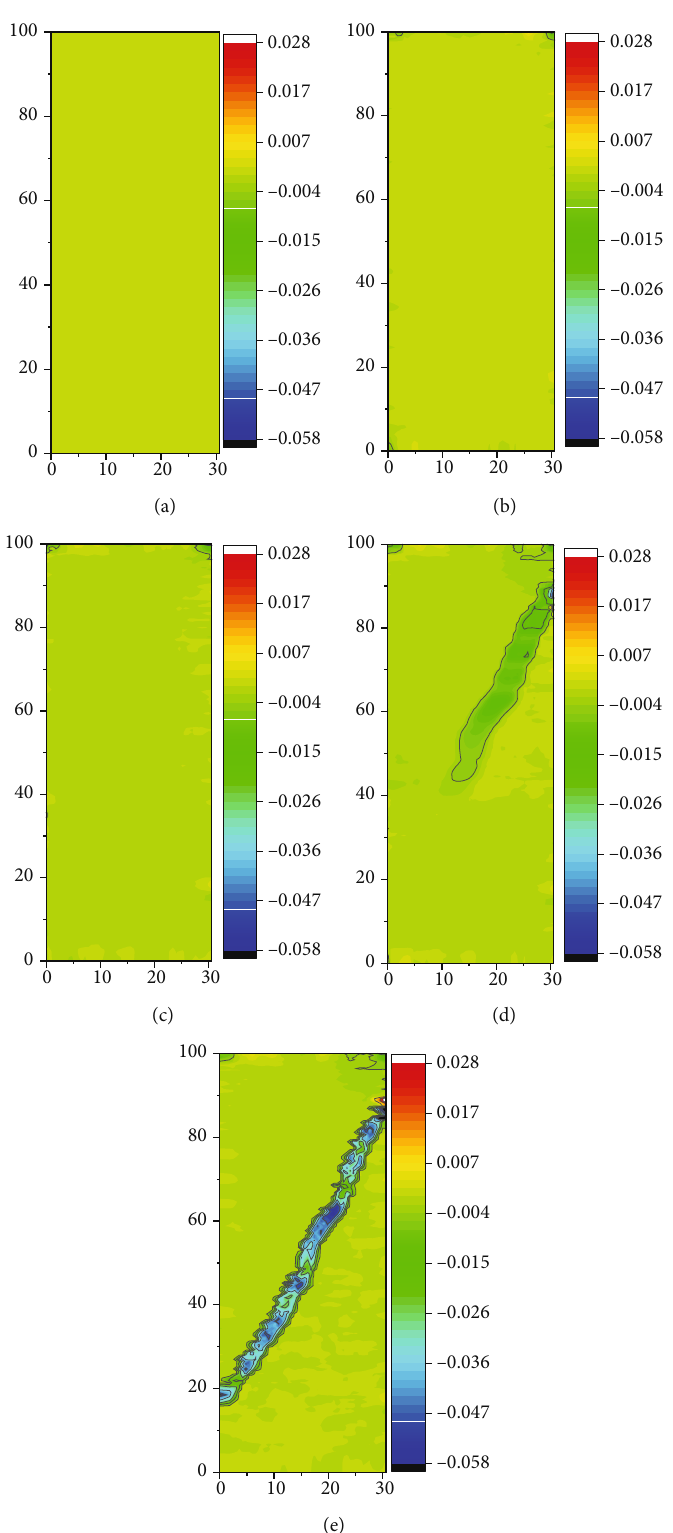
Figure 10: Shear strain distribution at (a) initial stage, (b) torsion application stage, (c) peak torque stage, (d) 22.5s after peak torque stage, and (e) 39 s after peak torque